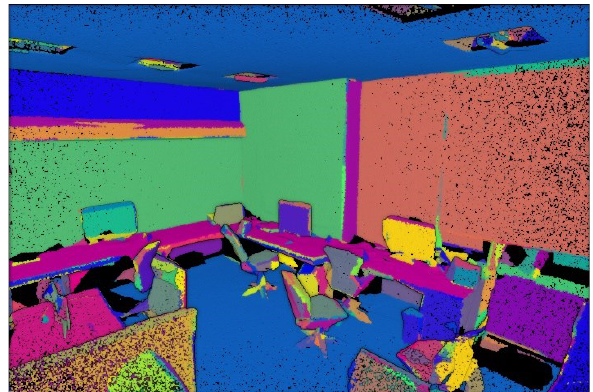
Figure 2 Segmentation results over an office